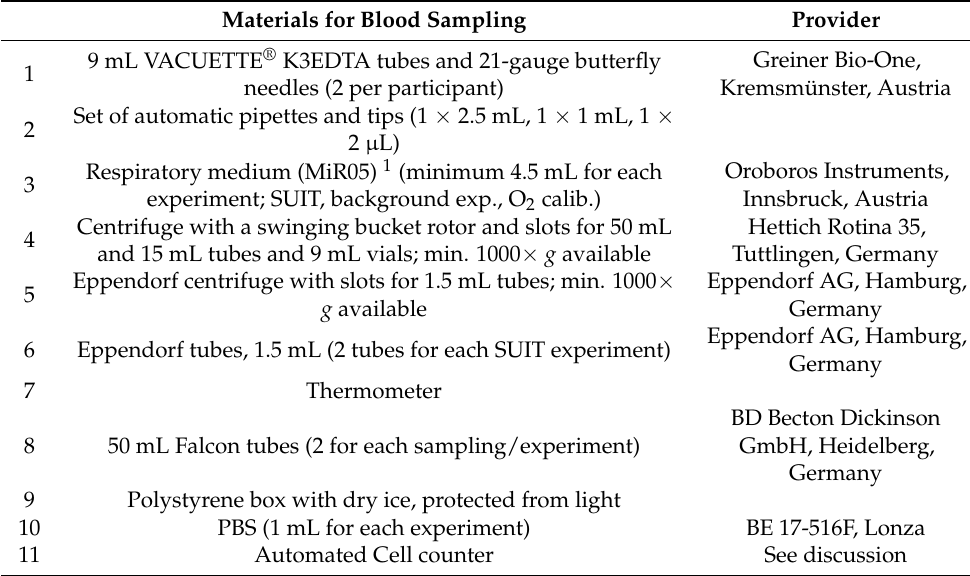
Table 1. Materials for blood sampling, O2k sample preparation, and subsample storage. Materials for Blood Sampling